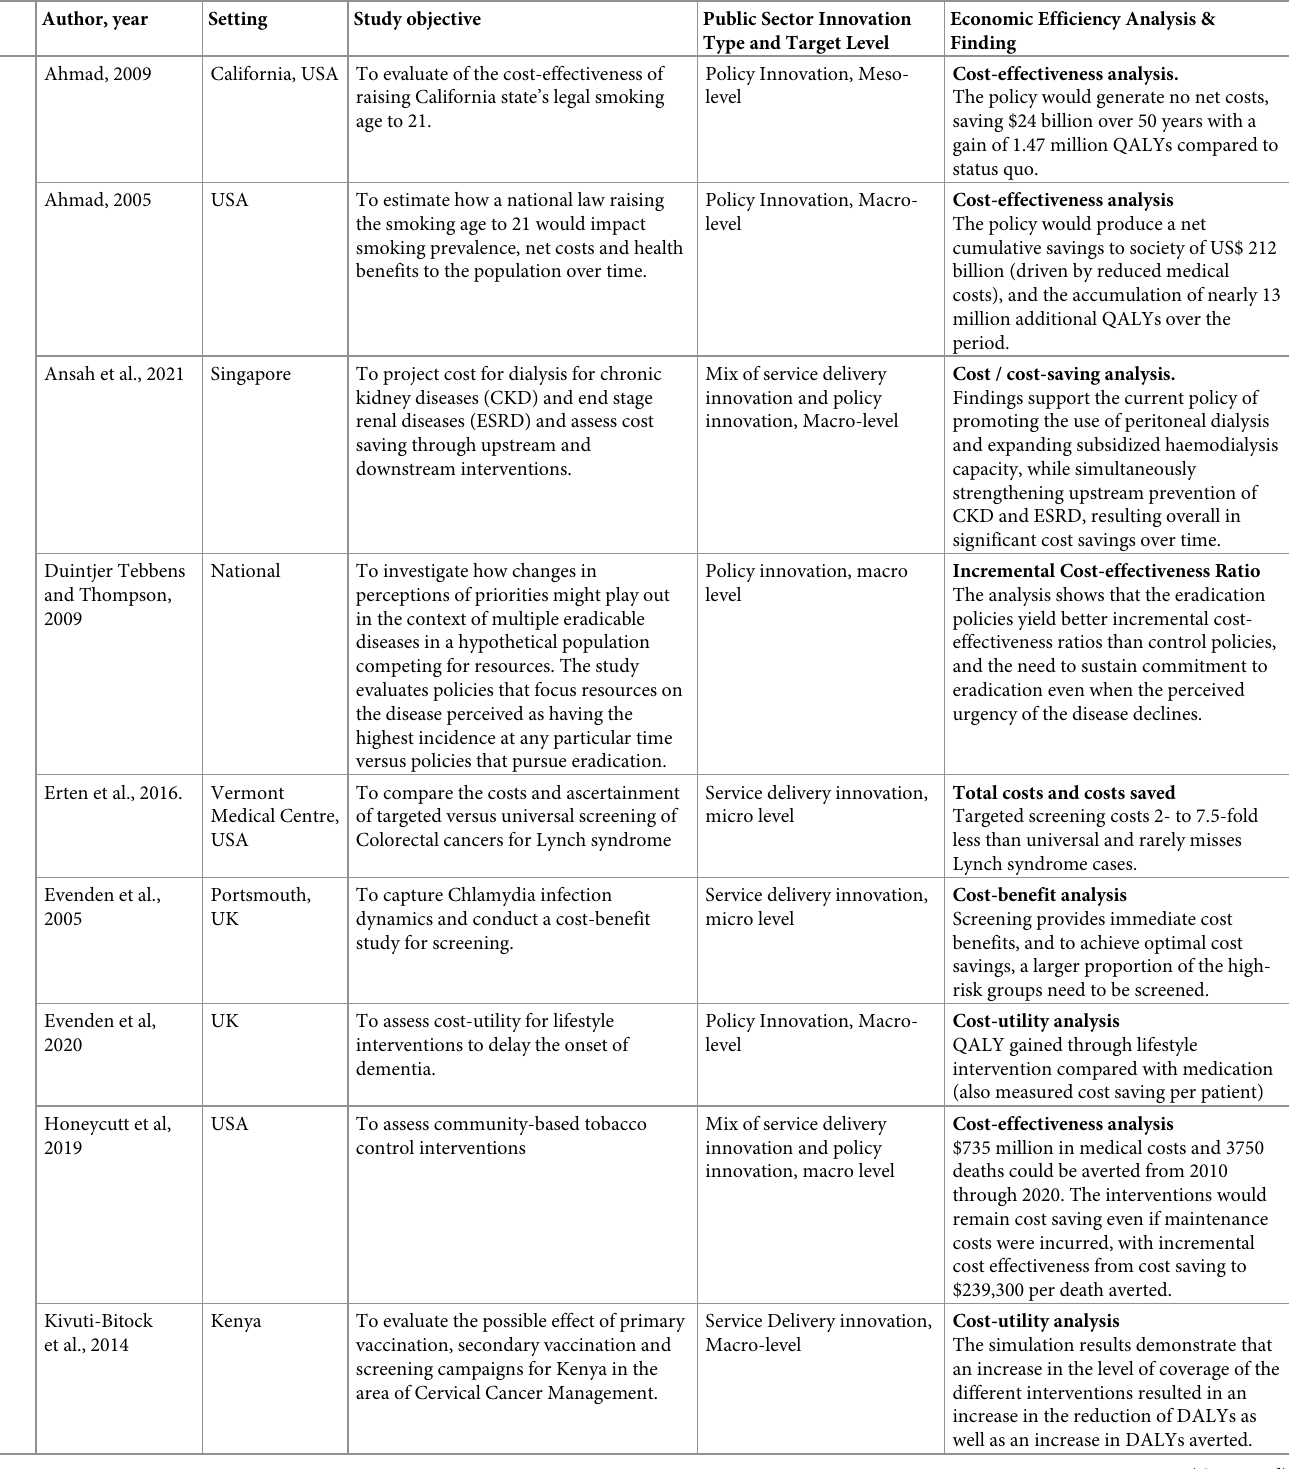
Table 1. General characteristics of selected